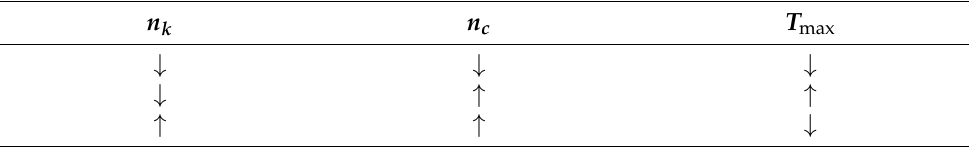
Table 3. Expected behavior of T max with n c and n k